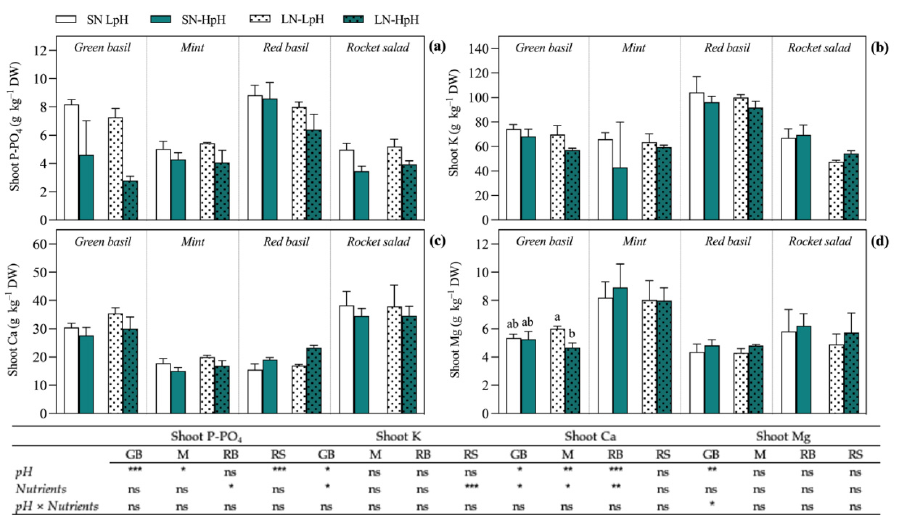
Figure 3. Shoot macronutrients of green basil (GB), mint (M), red basil (RB), and rocket salad (RS): P-PO 4 ( a ), K ( b ), Ca ( c ), and Mg ( d ). SN-LpH = standard nutrient concentration and standard pH (control); SN-HpH = standard nutrient concentration and high pH; LN-LpH = low nutrient concentration and standard pH; and LN-HpH = low nutrient concentration and high pH. Two-way ANOVA p -values and Tukey’s post hoc results are displayed in the figure (* = p ≤ 0.05; ** = p ≤ 0.01; *** = p ≤ 0.001; ns = not significant). Bars represent average values + SD.